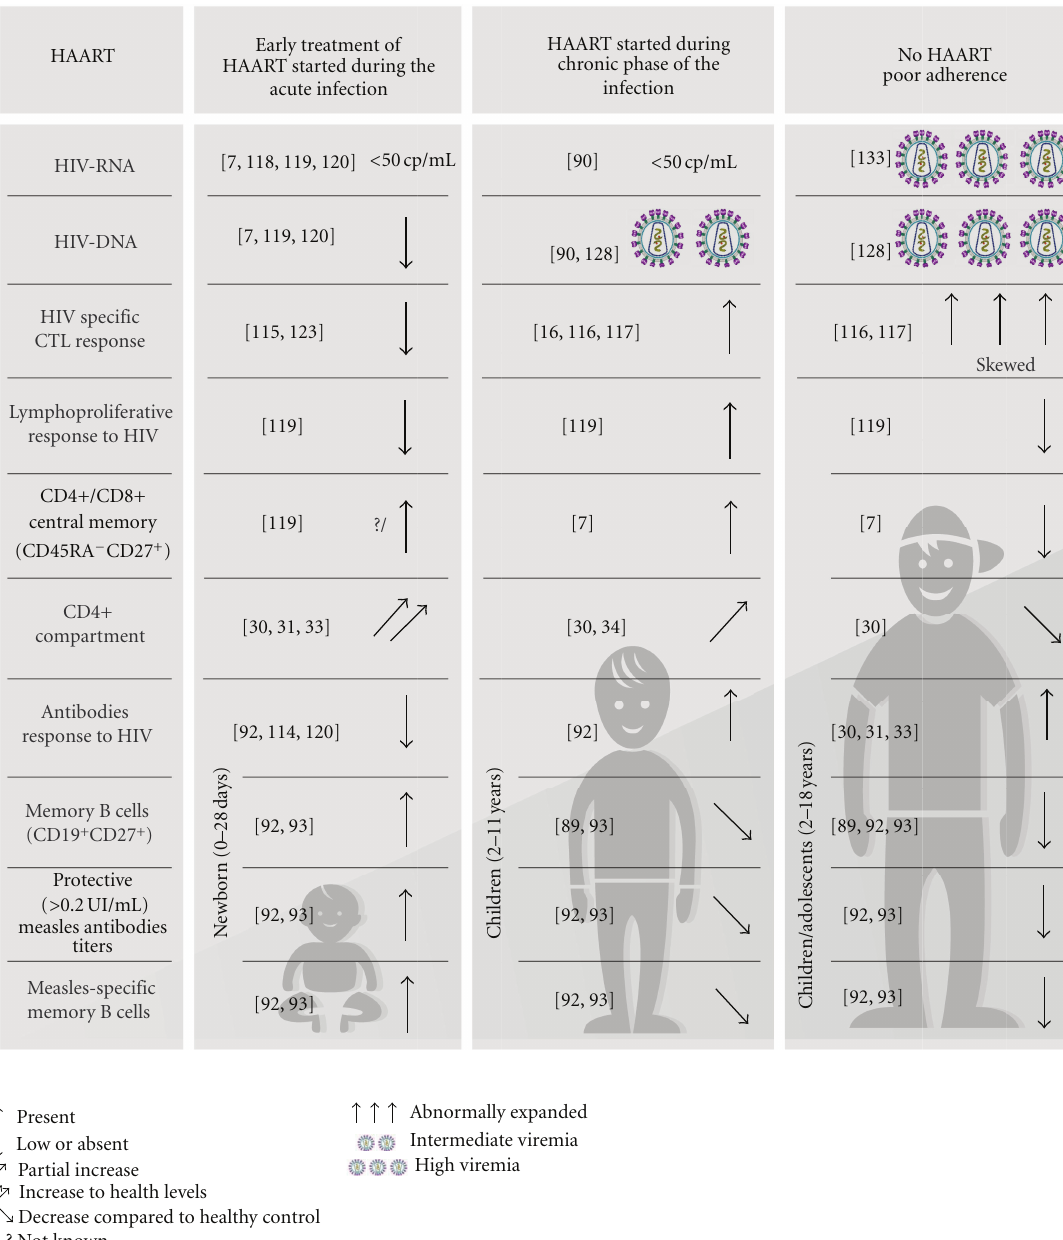
Figure 1: How timing of HAART initiation impact on B- and T-cell compartment and on viral